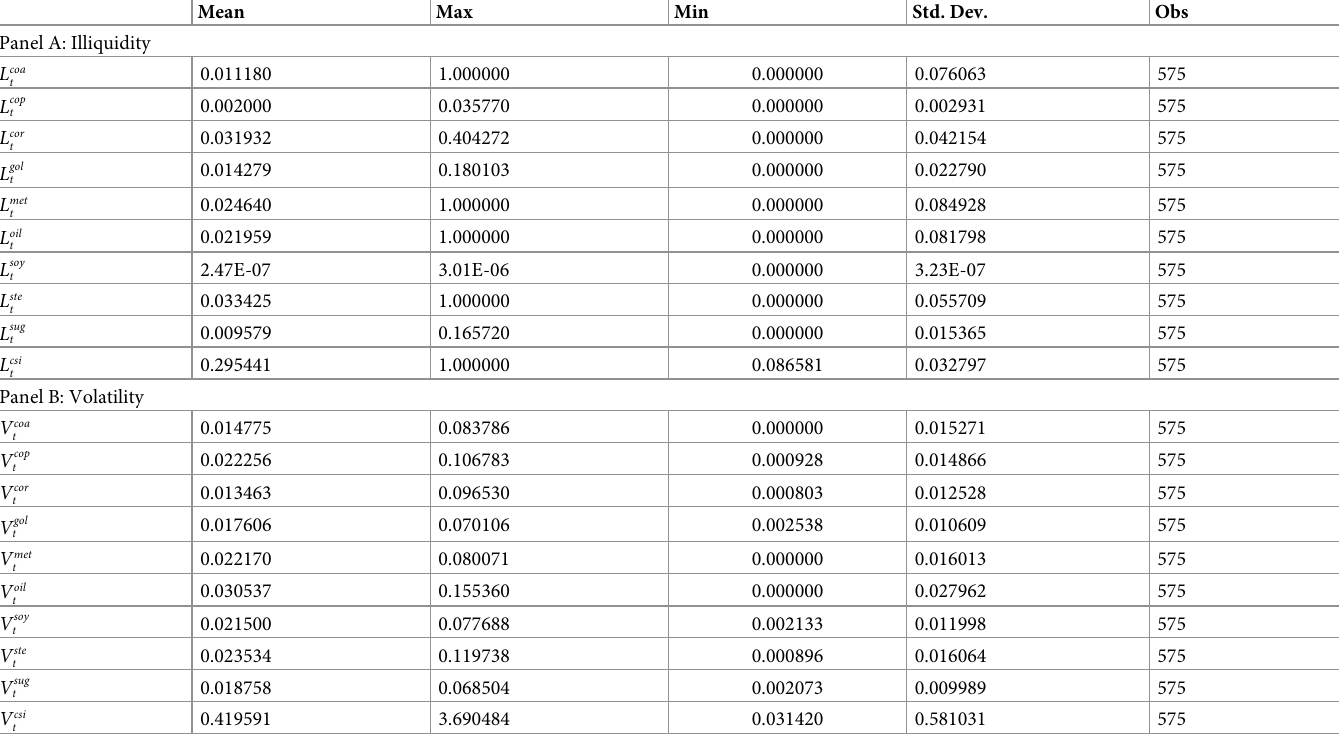
Table 1. Descriptive statistics of illiquidity and volatility. This table presents the mean, standard deviation (SD) for the illiquidity and volatility of each commodity mar- ket as well as the stock market. Illiquidity is measured using the Amihud measure for each market. The sample runs from January 1, 2010 to March 22, 2021. Mean Max Min Std.